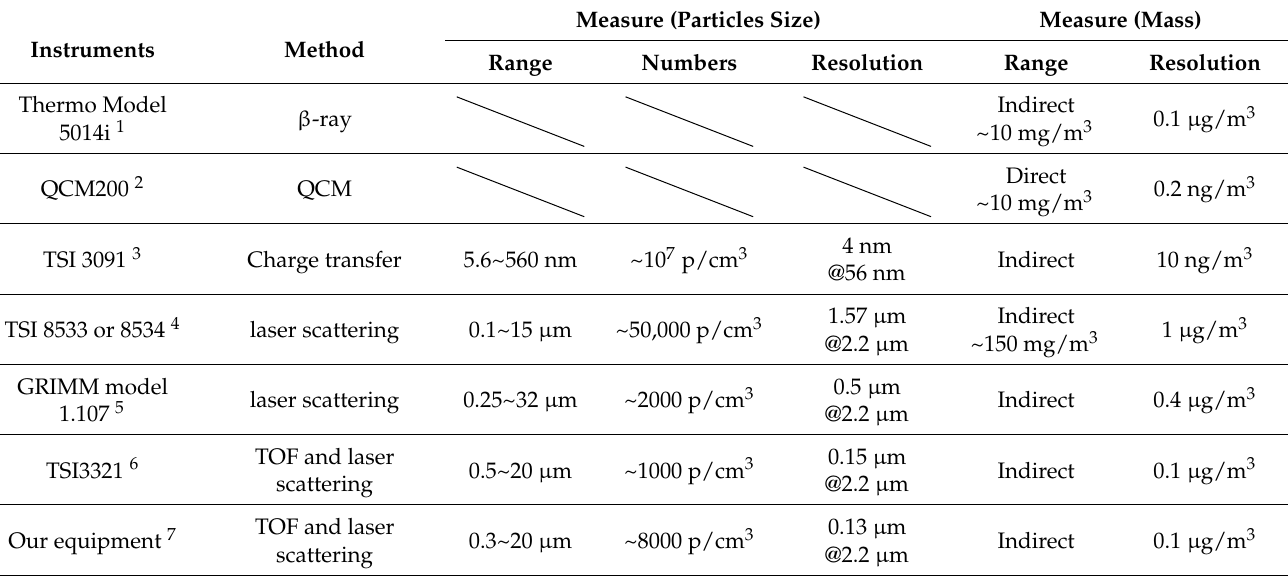
Table 4. Performance comparison of various instruments and